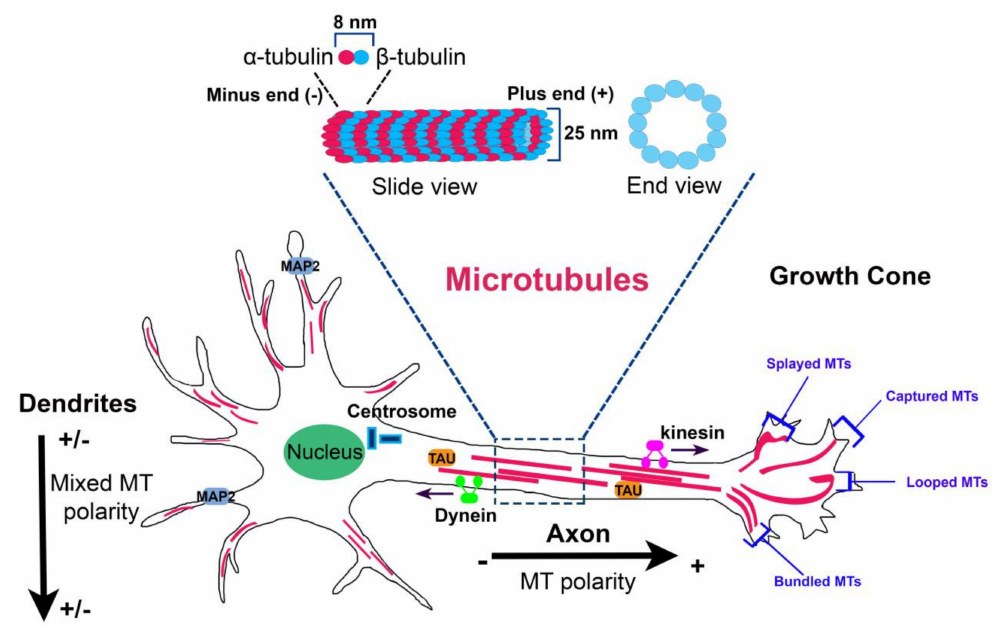
Figure 1. Microtubule organization in neurons. Microtubule (MT) organization is tightly regulated in the di ff erent neuronal compartments. In axon, MTs form stable, polarized bundles with uniform polarity orientation, exposing their plus minus ends away from the cell body. In proximal dendrites, MTs are organized in antiparallel bundles oriented with their plus ends pointing away or toward the soma. In the growth cone, MTs adopt four characteristic distributions: splayed, captured at the cortical matrix, looped, and bundled. At the top, MT structure (slide view and end view) is